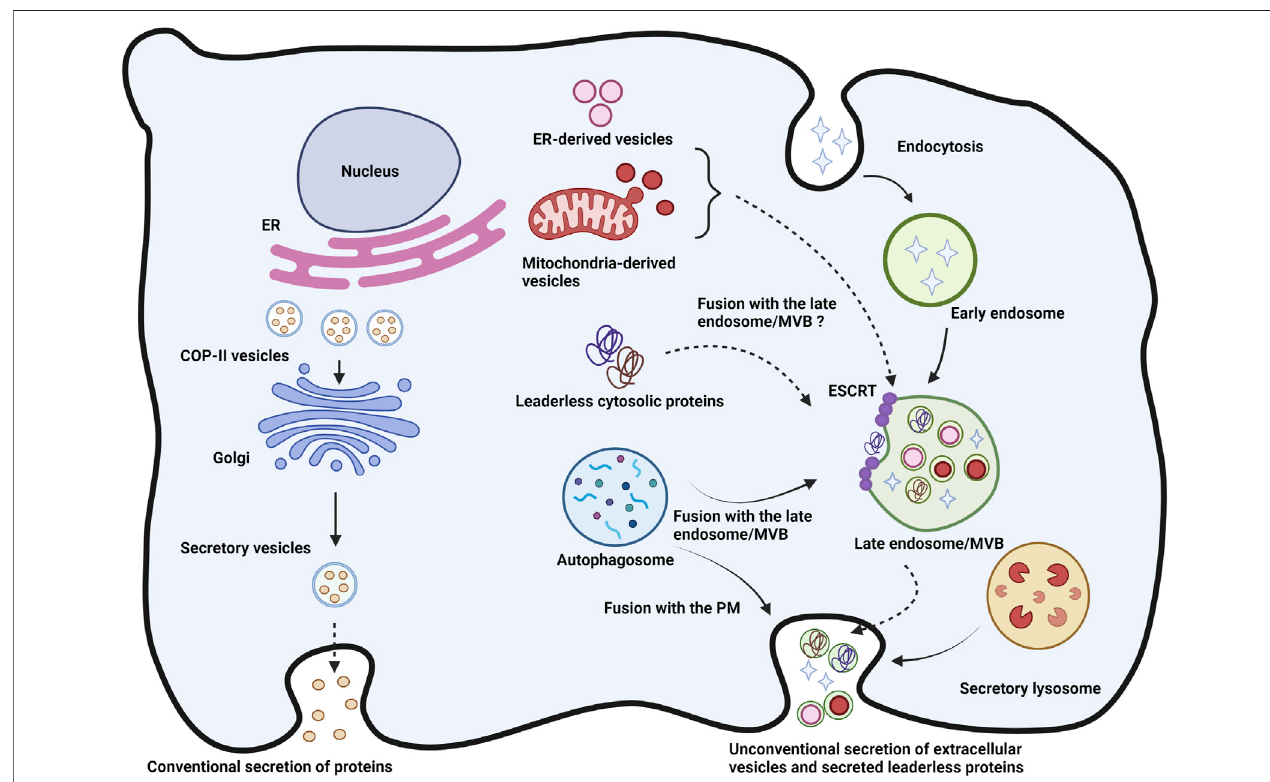
FIGURE 1 | Figure of unconventional vs. conventional secretions: Newly synthesized proteins from the ER and exported in COP-II vesicles towards the Golgi apparatus wherein they are packed in secretory vesicles for export via the conventional secretory pathway. Unconventional secretion, in particular the Type III secretion represented here involves packaging of cytosolic proteins as well as the possible targeting of autophagic, ER-derived and mitochondria-derived vesicles to the multivesicularbodies(MVBs)orlateendosomes.Theresultantintraluminalvesiclecanthenfusewiththeplasmamembraneandreleaseexosomesandothermixed content. Autophagosomes and secretory lysosomes can fuse with the plasma membrane directly to release their content in the extracellular space. MVB: Multivesicular body; ILV: Intraluminal vesicle; PM: Plasma membrane. Role of SNAREs and their partners in unconventional secretion.